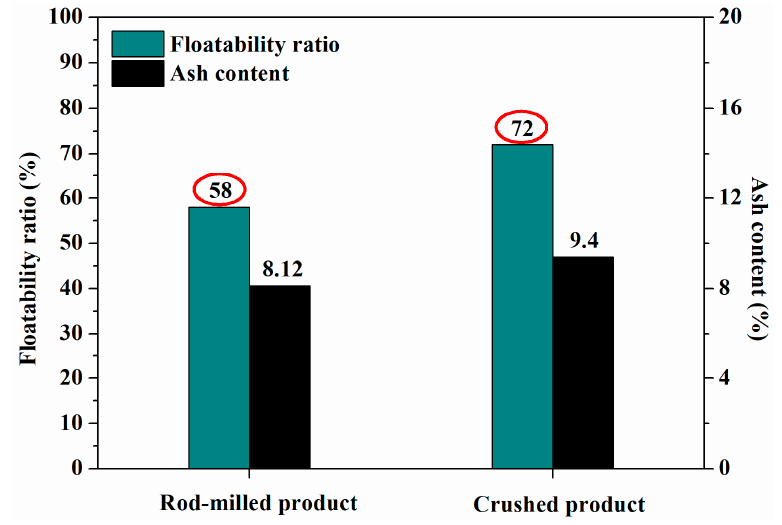
ff erent comminution